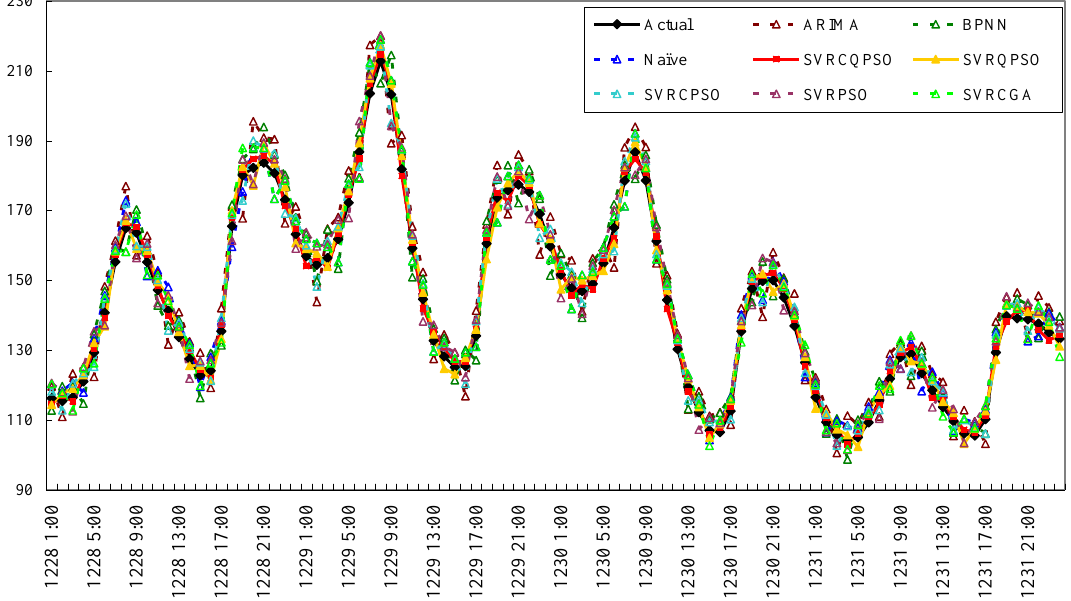
Figure 3. Actual values and forecasting values of SVRCQPSO, SVRQPSO, and other models (example three).